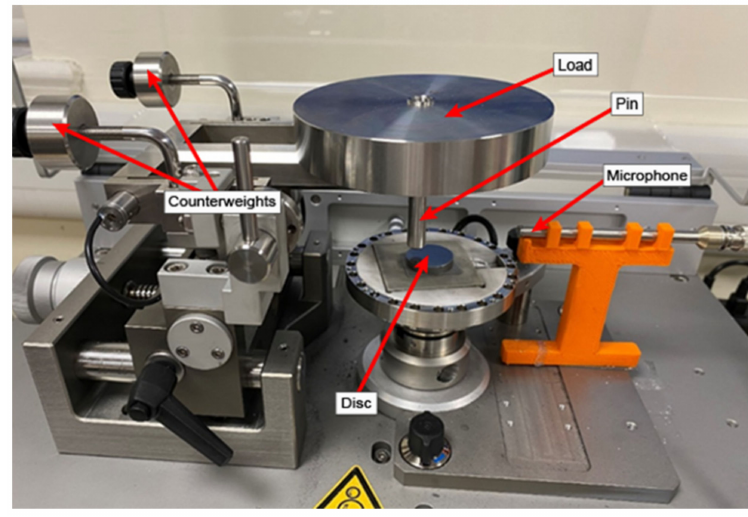
Figure 3. Close-up of the tribometer. Reproduced from Ref.